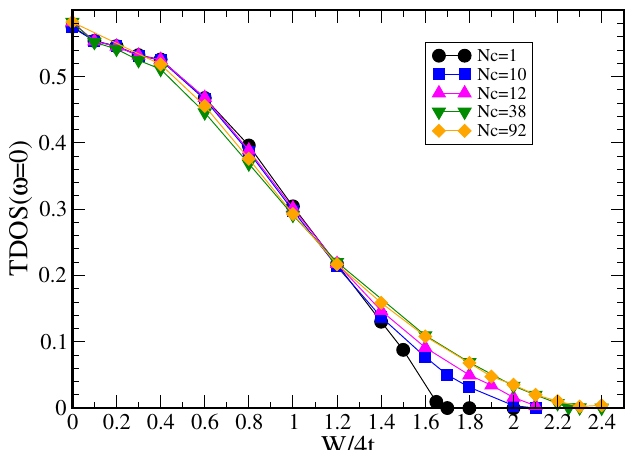
Figure 32. The TDOS at the band center TDOS ( ω = 0 ) vs. disorder strength W for the 3D Anderson model calculated with the TMDCA using Ansatz 1 for different cluster sizes N c = 1,10,12,38,92 with units where 4 t = 1. The TDOS ( ω = 0 ) vanishes at the critical disorder strength W c when all states become localized. For N c = 1, which corresponds to the TMT method, the critical disorder strength 1.65. As cluster size N c increases, the critical disorder strength W c increases quickly to W c ( N c = 1 ) ≈ 2.25, which is in very good agreement with the results from the TMM W c ≈